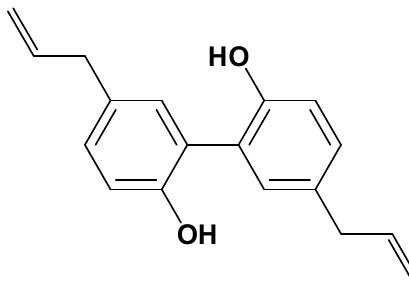
Figure 1. Chemical structure of magnolol.